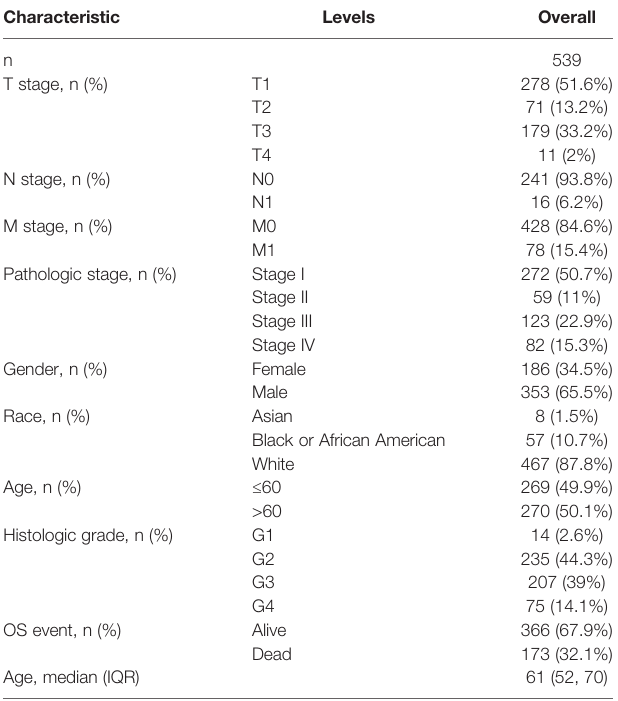
TABLE 1 | Clinical characteristics of the kidney renal clear cell carcinoma patients.